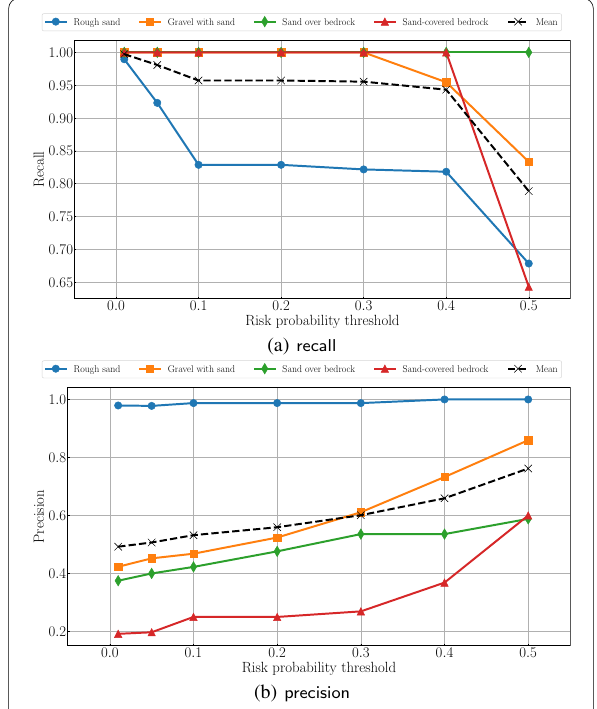
Fig. 15 Classification scores in Evaluation 4. a Recall and b precision scores of varied risk probability thresholds, p threshold , are plotted for the four target domains. The mean of the four domains is also